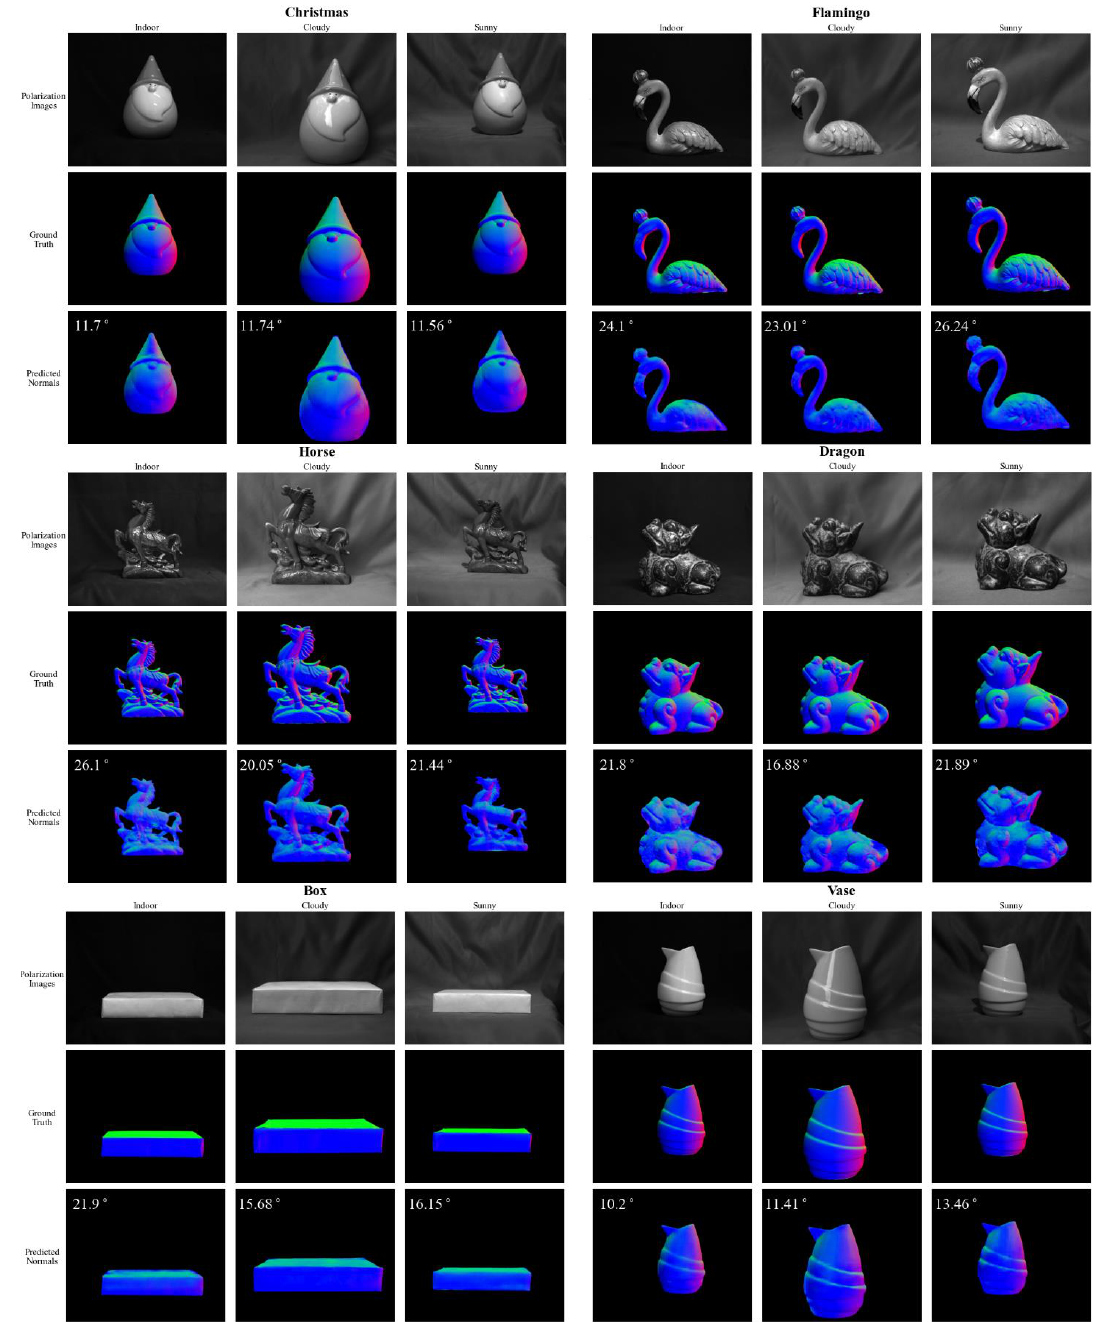
Figure 6 . Reconstructed surface normal of objects in three different lighting